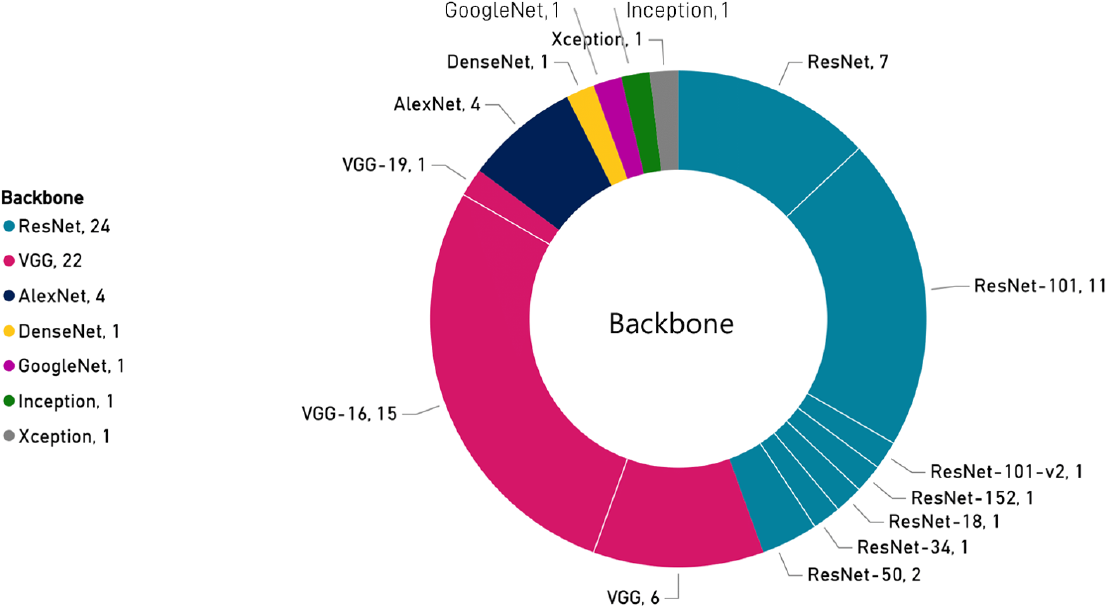
Figure 4. Overview of the deep learning (DL) architectures employed. The encoder-decoder models like Fully Convolutional Network (FCN), U-Net, SegNet, DeepLab, Hourglass and others are the most commonly employed ones. Many papers have employed more than one of these architectures to later fuse the output feature maps.